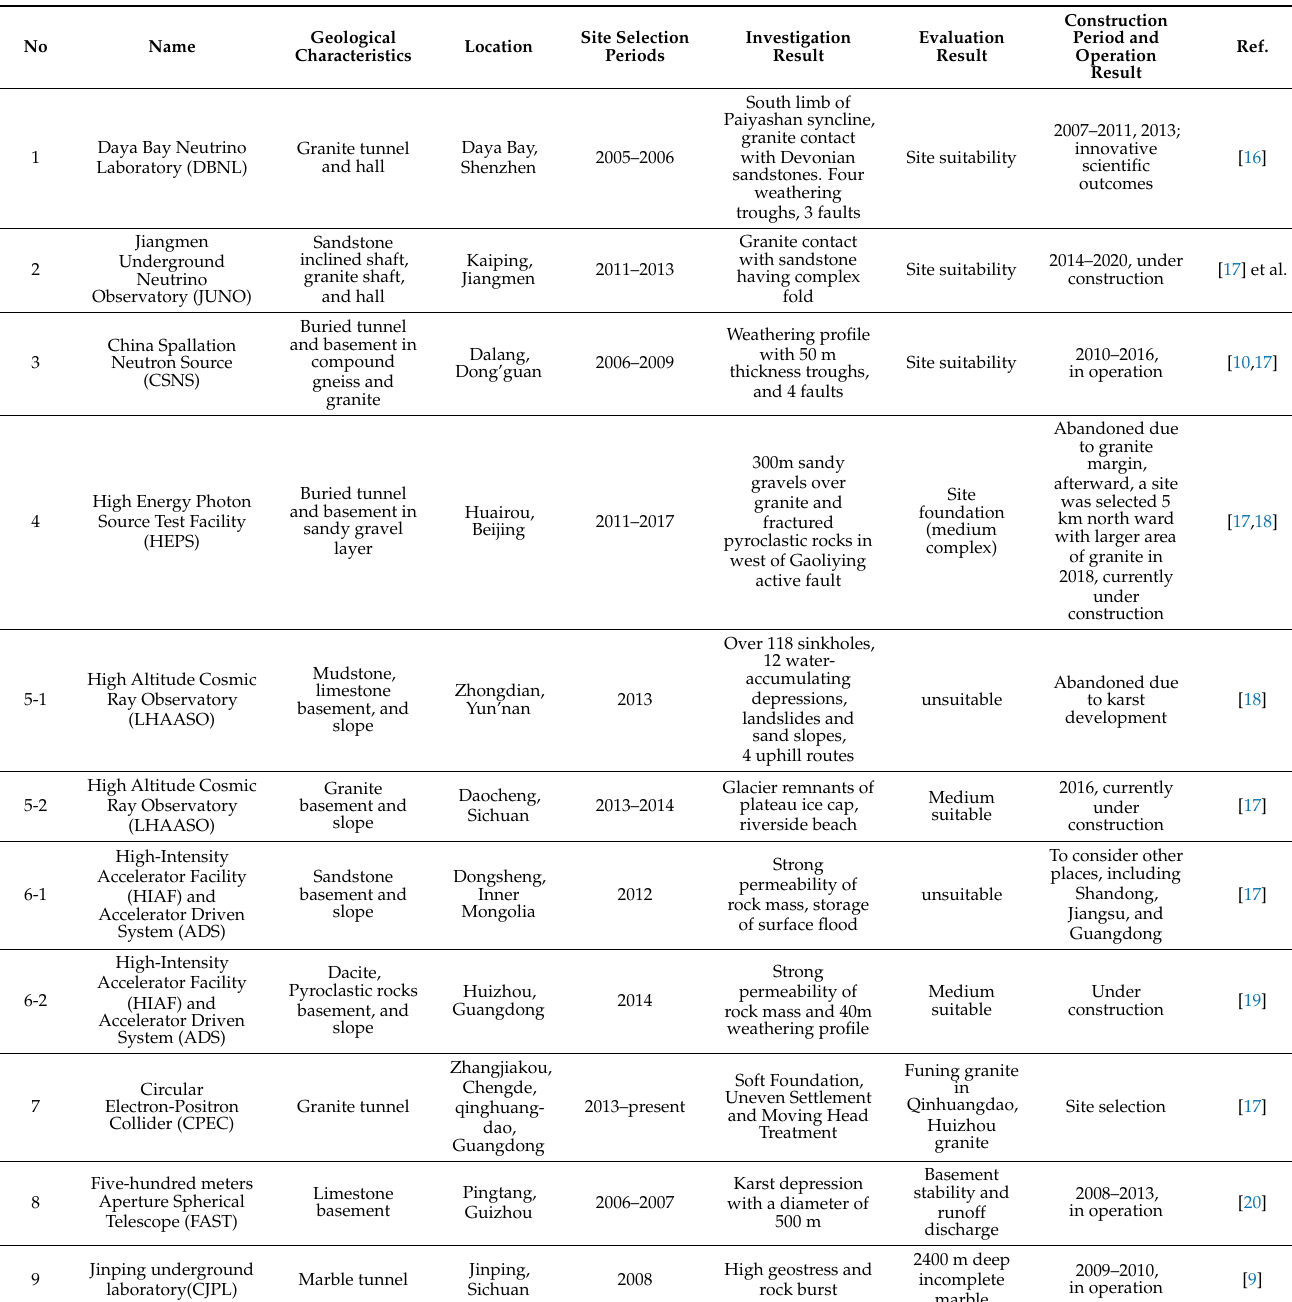
Table 1. The nine large-scale RIs (corresponding to the RIs labeled with numbers in Figure 1a) in various stages of completion in